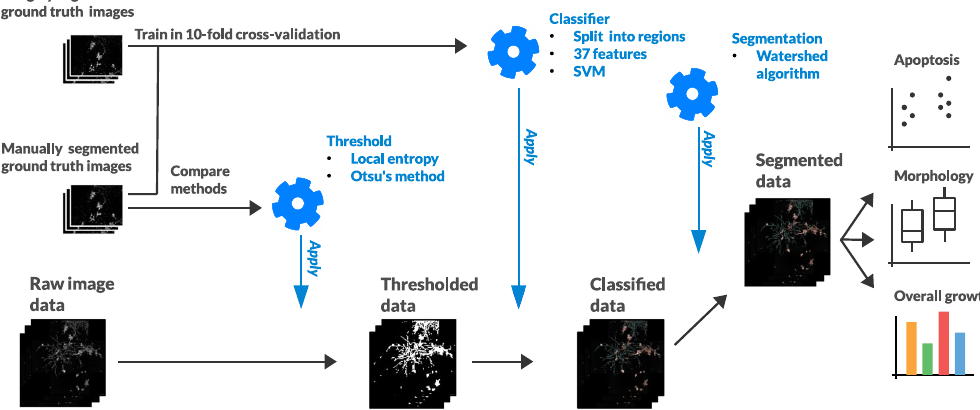
Figure 3. The complete chain of computational methods and their derivation. Below, the data processing steps are illustrated starting from the raw image data and ending with the classified and segmented data. Above, the development of the related methods is shown and their points of application are specified. The raw data are first thresholded using Otsu’s method on the local entropy filtered images. This approach was evaluated using a manually generated ground truth. The thresholded data are then classified between the two cell types with the SVM trained using 10-fold cross-validation. The data are then segmented into individual cell structures using the well-known Watershed algorithm. Finally, the overall growth, morphology and the number of very small structures are subjected to statistical